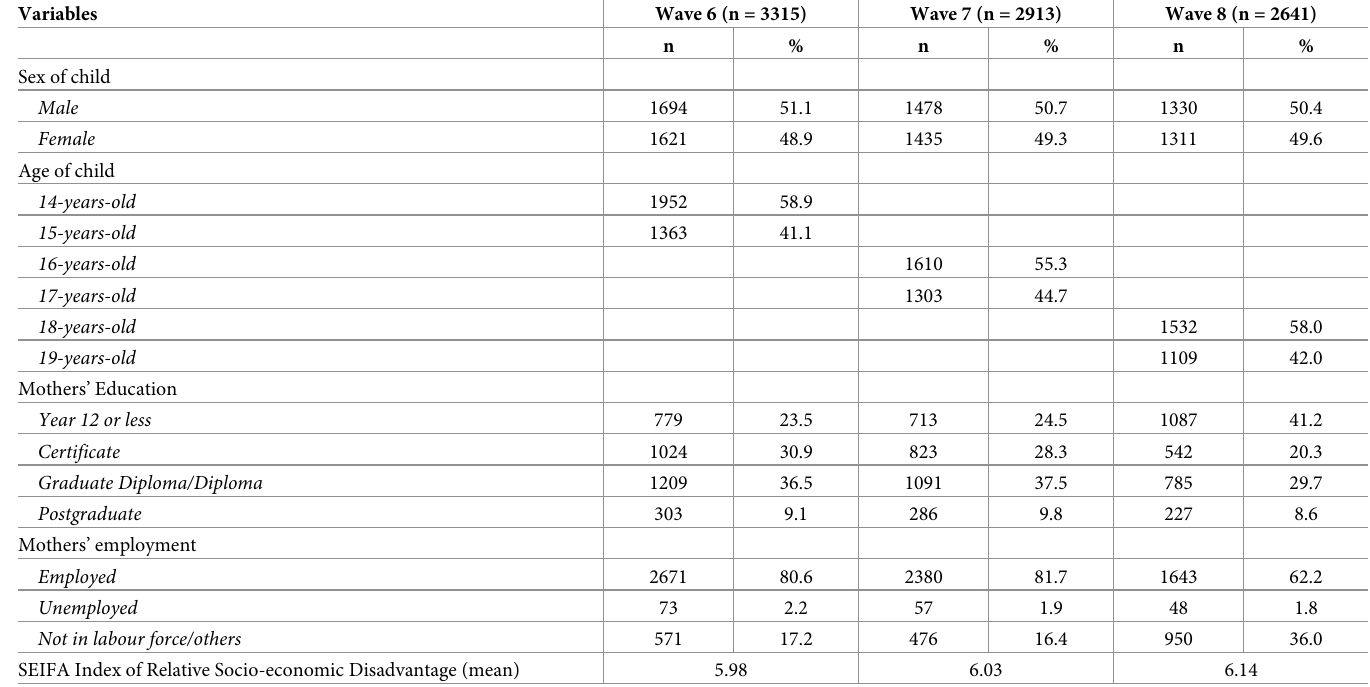
Table 1. Characteristics of the study participants and the